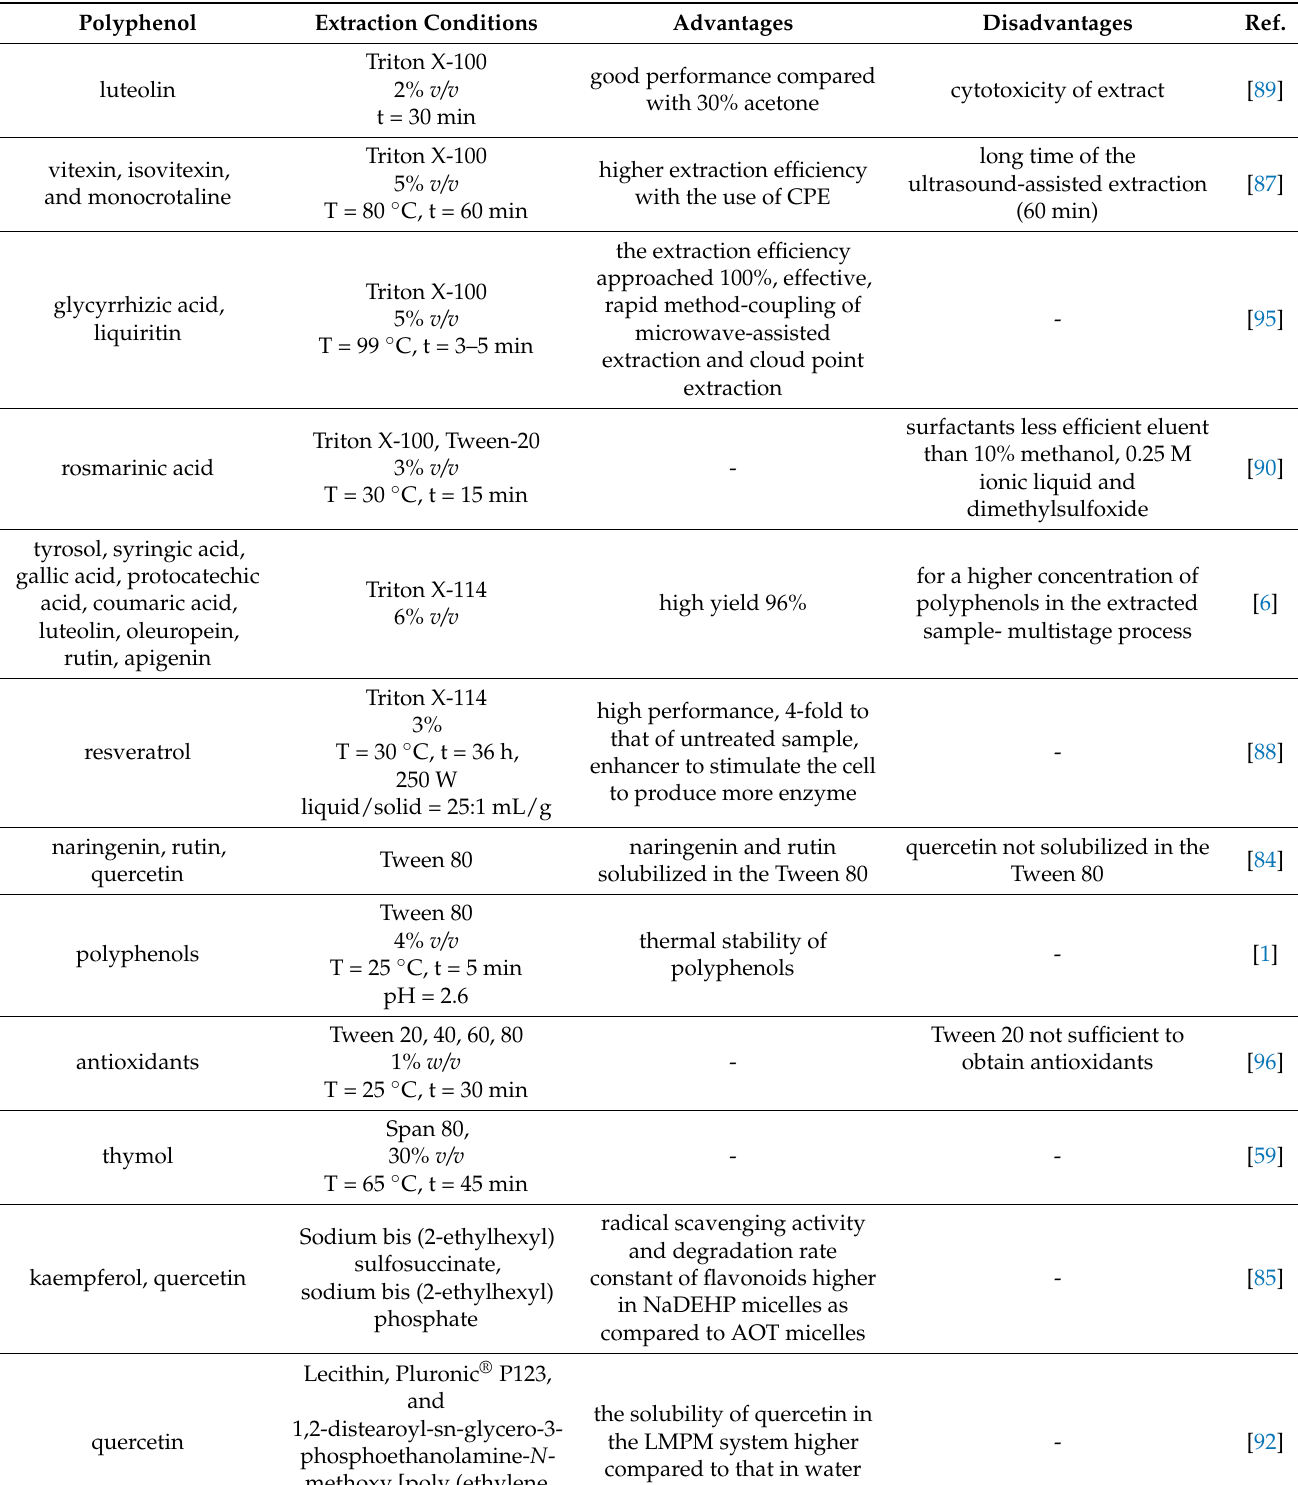
Table 3. Characteristics of surfactant-assisted extraction techniques used to source polyphenols.